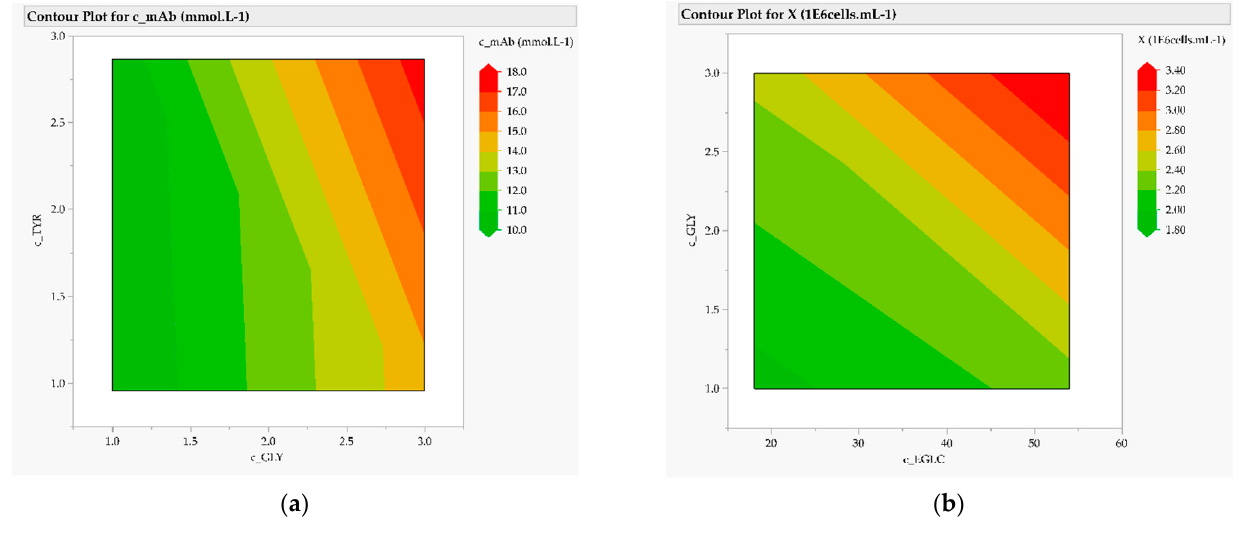
Figure 8. Contour plots for ( a ) mAb concentration and ( b ) viable cell density.